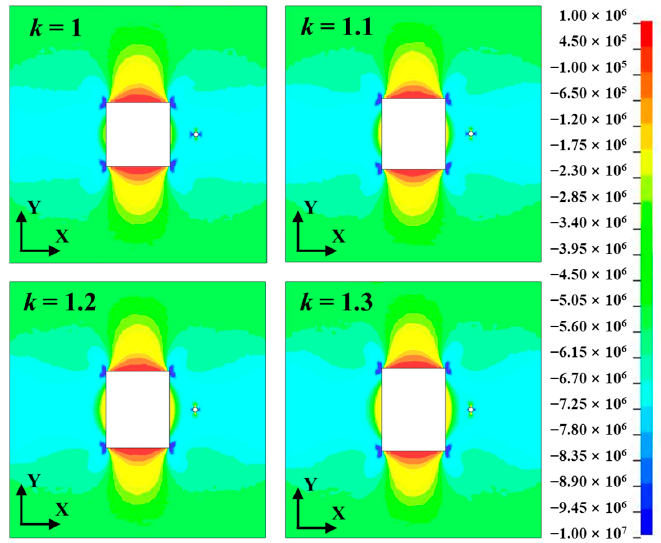
σ ) with different k under P1 = P2 = 5 MPa. Figure 12. Y-direction elastic stress fields ( σ y ) with different k under P1 = P2 = 5 MPa.